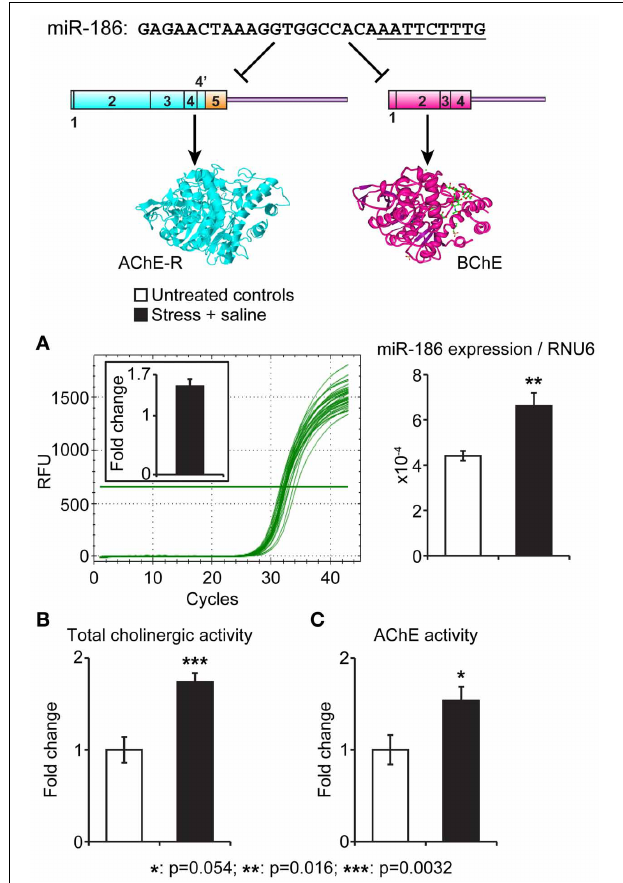
FIGURE 3 | Intestinal miR-186 increases under predator scent stress are accompanied by elevated BChE and AChE activities. Top: The nucleotide sequence of the BChE and AChE-R-targeting miR-186 and schemes of its AChE-R and BChE mRNA targets. The “seed” sequence is underlined. (A) qRT-PCR quantification normalized to RNU6 levels demonstrates reproducible RFU values and 1.6-fold excess of miR-186 in intestinal sections from stressed mice, 7 days post-predator scent exposure ( p = 0 . 016). (B,C) Highly significant intestinal elevation of total acetylthiocholine hydrolytic activity ( p = 0 . 0032) accompanied by less pronounced AChE activity measured in the presence of 10 μ M iso-OMPA ( p = 0 . 05). N = 5 mice per group, in all